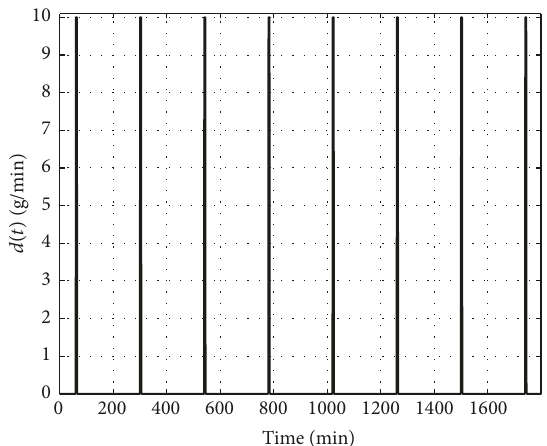
Figure 10: Applied disturbance (CHO intake)— 10 g over 5 minutes at each 240 th time